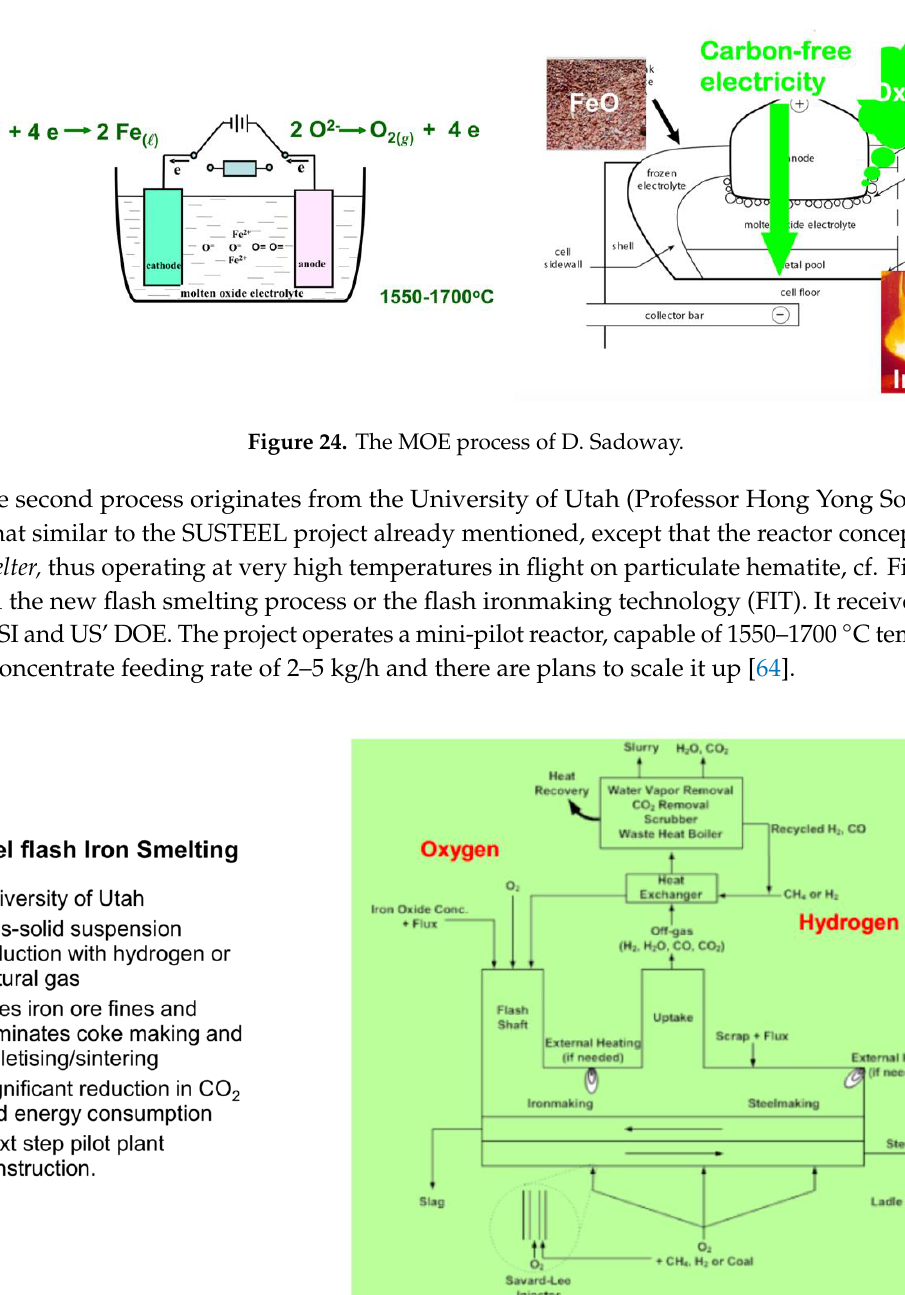
Figure 25. New flash melting process, University of Utah.